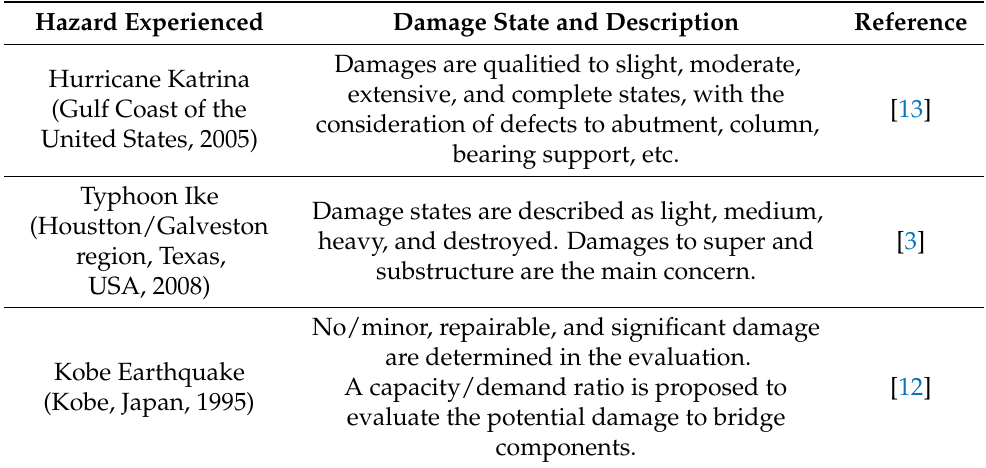
Table 2. Examples of damage state evaluation of